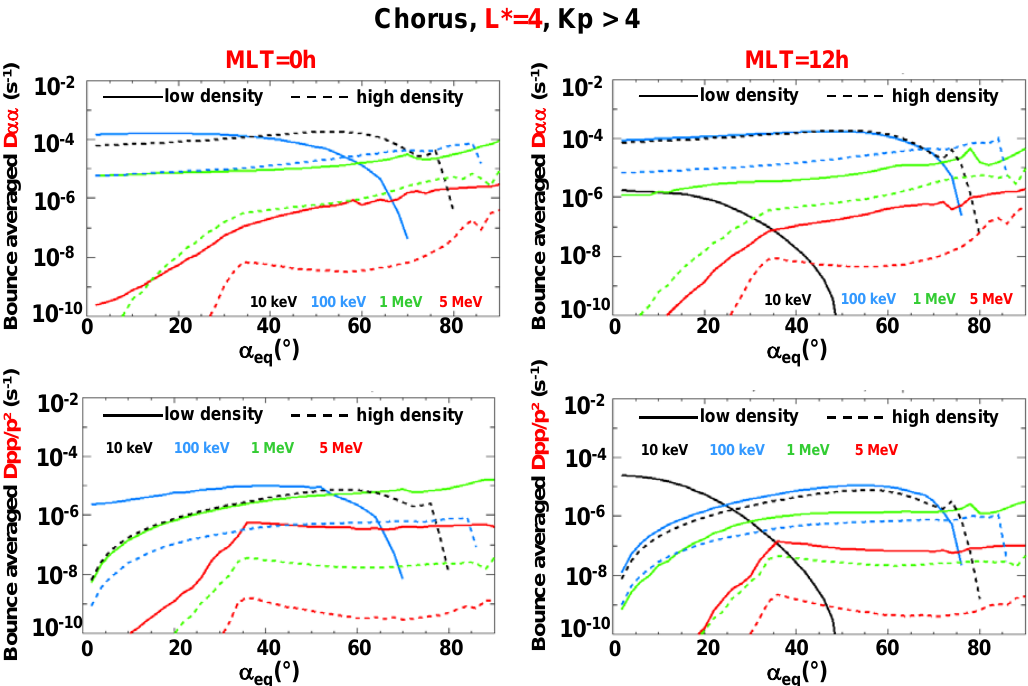
Figure 3. Bounce-averaged pitch angle (top) and energy (bottom) diffusion rates (s − 1 ) for chorus using WAPI code for 4 energies, 0.01MeV Fig. 3 Bounce-averaged pitch angle (top) and energy (bottom) diffusion rates (s -1 ) for chorus 683 (black), 0.1MeV (blue), 1MeV (green) for and 5MeV (red) L ∗ = 4 and for MLT = 0h on the left and MLT = 12h on the right for active magnetic activity (Kp > 4) and for two different plasma densities: 5th percentile in solid lines and 95th percentile in dashed lines. using WAPI code for 4 energies, 0.01 MeV (black), 0.1 MeV (blue), 1 MeV (green) for and 5 684 MeV (red) L*=4 and for MLT=0h on the left and MLT=12h on the right for active magnetic 685 activity (Kp>4) and for two different plasma densities: 5 th percentile in solid lines and 95 th 686 percentile in dashed lines. 687